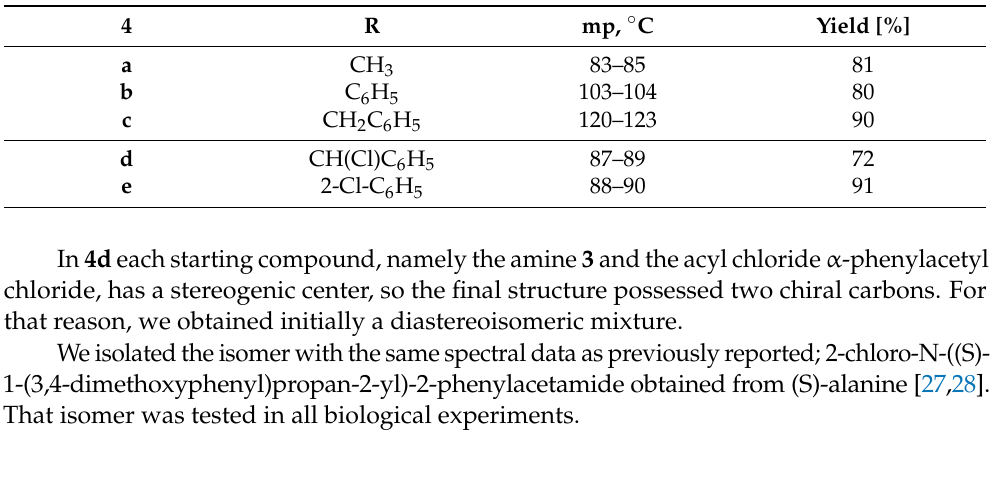
Table 2. Synthesis of N-(1-(3,4-dimethoxyphenyl)propan-2-yl) amides 4